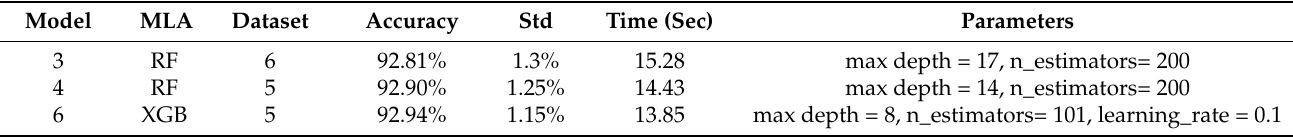
Table 12. Performance improvement of the models after applying a heatmap (second testing stage, second improvement